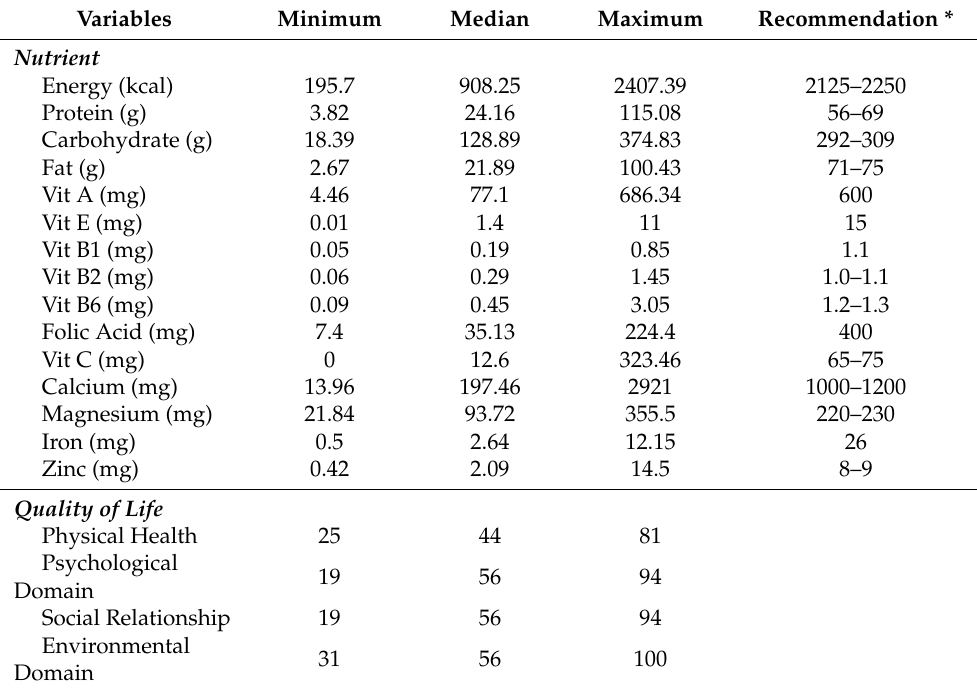
Table 2. Nutrient Intake and Quality of